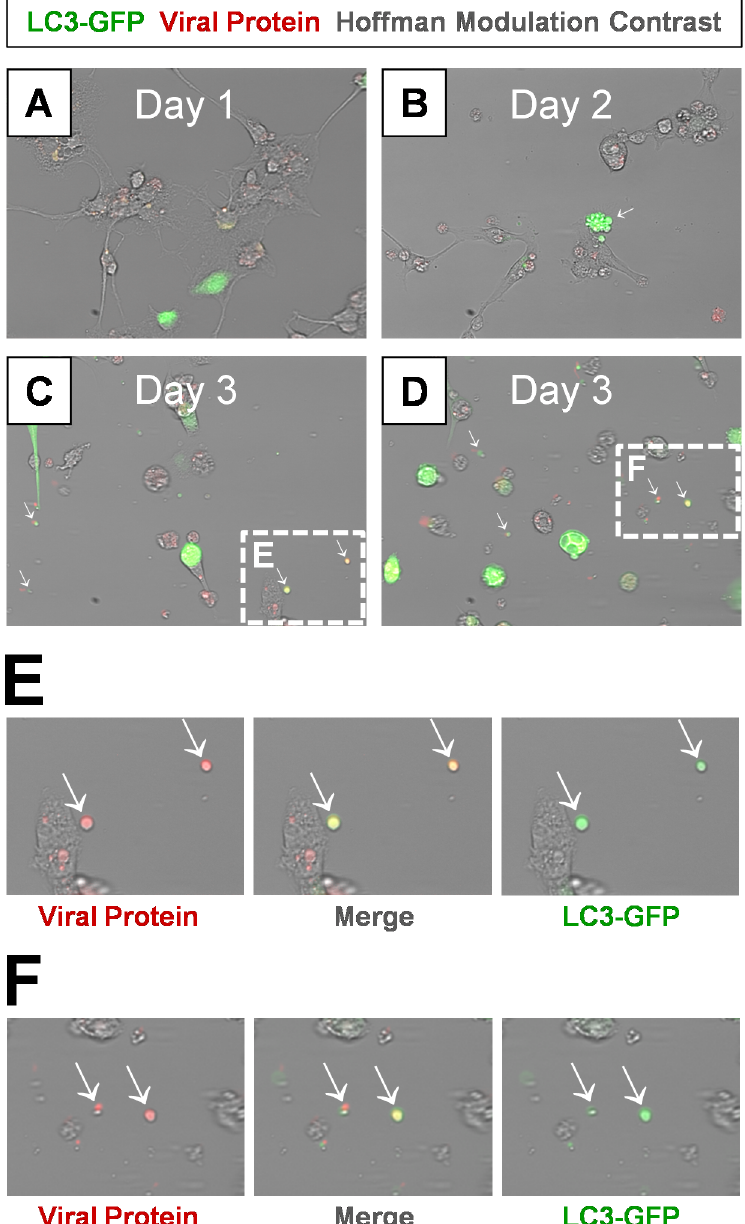
Figure 10. Detection of LC3 protein in shed EMVs containing viral protein. Differentiated NPSCs transduced with adeno-LC3-GFP were infected with dsRED-CVB3 (moi=0.1) and observed by fluorescence microscopy up to 3 days PI. (A) Transduced NPSCs (green) and viral protein expression (red) were readily observed by day 1 PI. (B) Differentiated NPSCs infected with virus showed signs of cellular blebbing by day 2 PI (white arrow). (C–D) Abundant shed EMVs were readily observed by day 3 PI. EMVs (white arrows) contained viral protein (red) and expressed a marker for autophagosomes (LC3-GFP, green). (E–F) Higher magnification of (C) and (D) showed colocalization of viral protein and LC3-GFP in shed EMVs. Shed microvesicles express viral protein 1 (VP1), high levels of LC3 II, and flotillin-1 Purified EMVs were also inspected by western analysis for the presence of CVB3 viral protein 1 capsid protein (VP1), LC3 I and II, and flotillin-1 ( Figure 12B ). LCII (lipidated form of LC3) studs the inner and outer autophagosome membrane and reflects autophagic activity in cells [24]. Flotillin-1 is a caveolae-associated membrane protein identified as a common marker on exosomes [42], and at compartments of the endocytic and autophagosomal released as single membrane vesicles [43] [35]. Taken together,